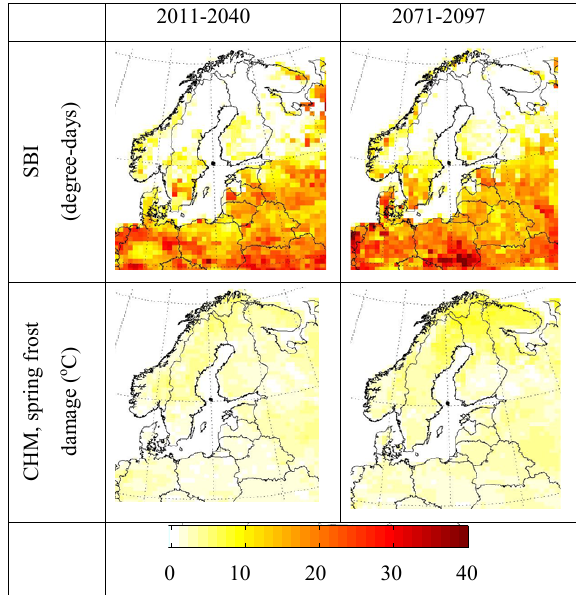
Figure 10. The standard deviation of the projected SBI and the CHM maximum frost Fig. 10. The standard deviation of the projected SBI and the CHM maximum frost damage, calculated using temperature data from damage, calculated using temperature data from RCA3 driven at the boundary conditions RCA3 driven at the boundary conditions with output from an en- with output from an ensemble of seven GCM data, calculated for the time slices of 2011- semble of seven GCM data, calculated for the time periods of 2011– 2040 and 2070–2097. Note that the two indices have different units, 2040 and 2070-2097. Note that the two indices have different units, leading to different leading to different degrees of degree of variability.